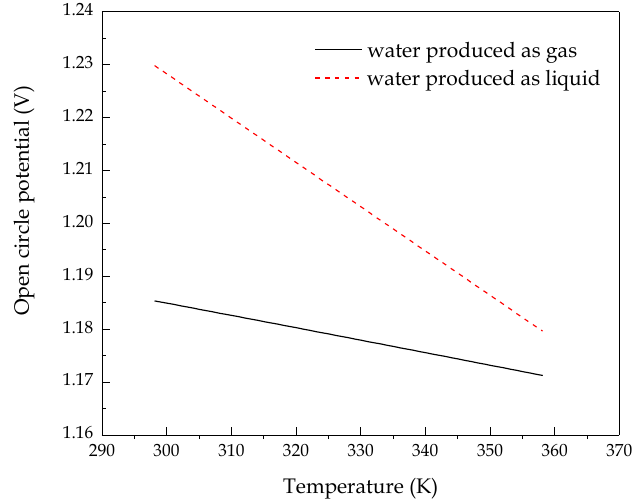
Figure 3. Temperature dependent open circuit potential for the PEM fuel cell.